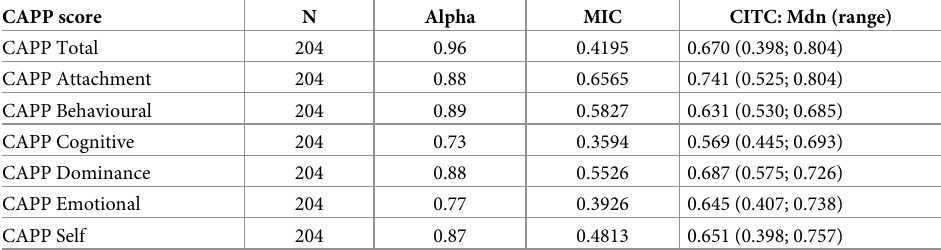
CAPP: Comprehensive Assessment of Psychopathic Personality; MIC: mean inter-item correlation; CITC: corrected- item total correlation; Mdn: median.